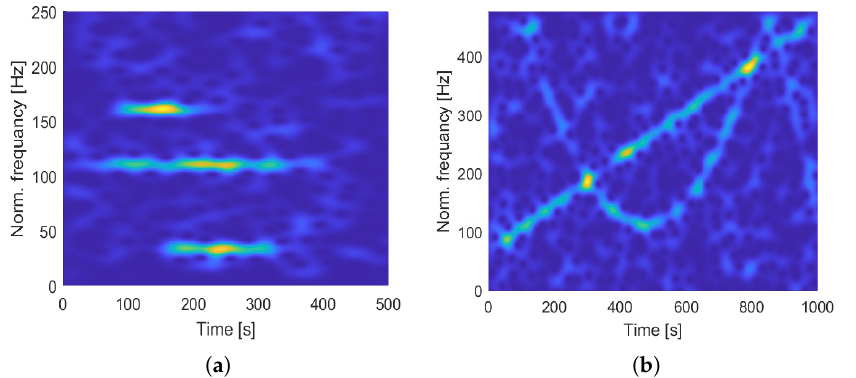
Figure 6. Time-frequency distributions of two signals for SNR = 0 dB. ( a ) Time-frequency distribution of the first signal. ( b ) Time-frequency distribution of the second signal.